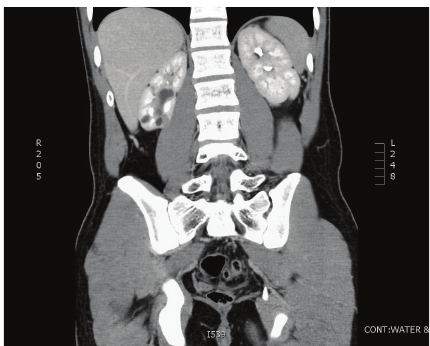
Figure 3: CT scan with contrast showing dilated calyces and associated cortical thinning in the lower pole of the right kidney. The left kidney appears